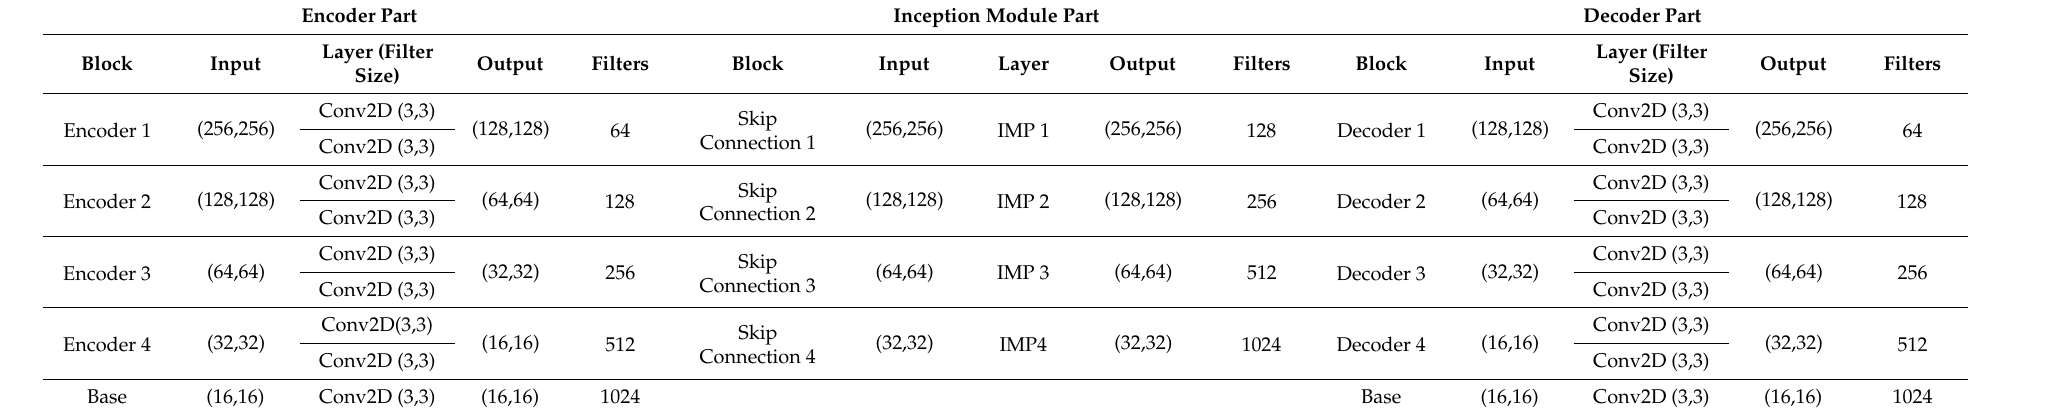
Table 1. The input, output and number of filters for proposed model